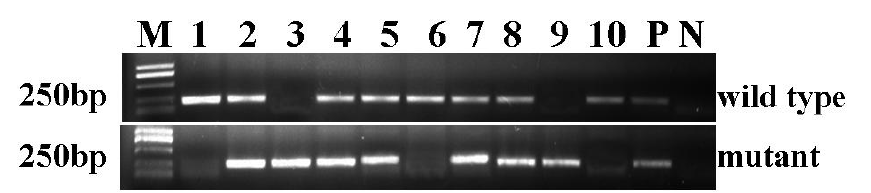
Figure 1. Genotyping of Lmna in the mice. PCR was applied to detect the Lmna allele in the mice. The upper bands indicate wild-type alleles. The lower bands indicate mice that possess the Lmna homozygous deletion. Mice with both bands are heterozygous. M =